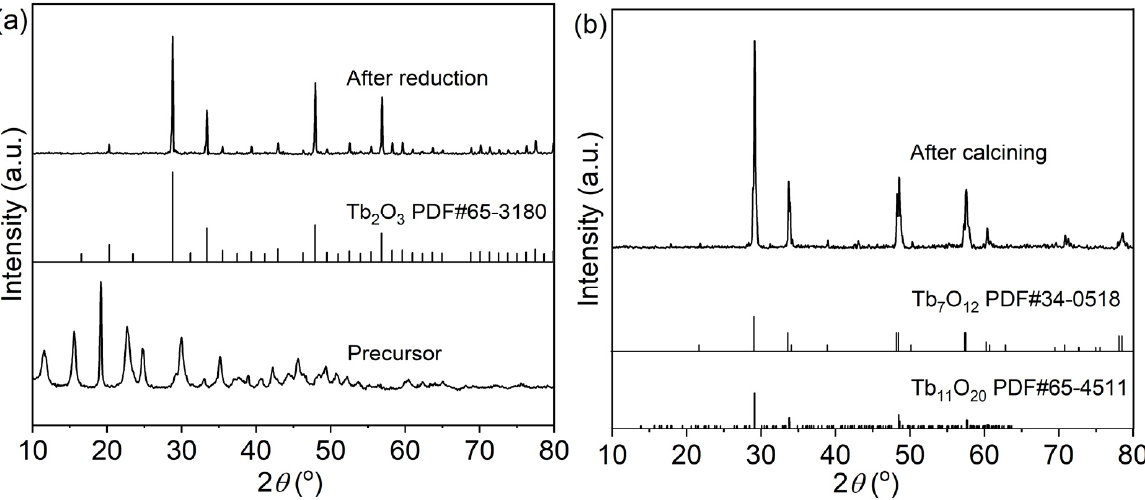
Figure 3. XRD patterns of the precursor and reduced powder ( a ), and the calcined powder ( b ).